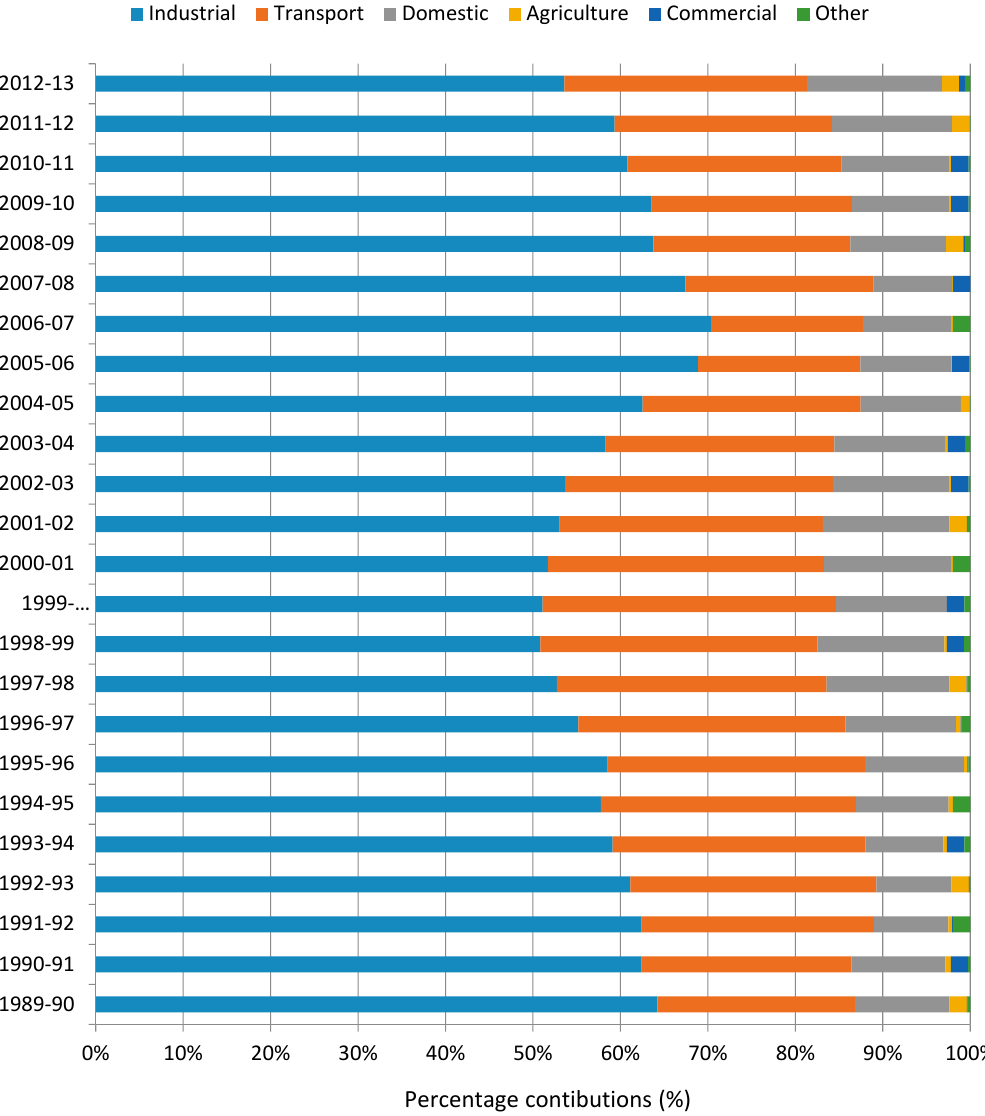
Figure 7. Sensitivity analysis of total energy consumption for year 2012–2013.